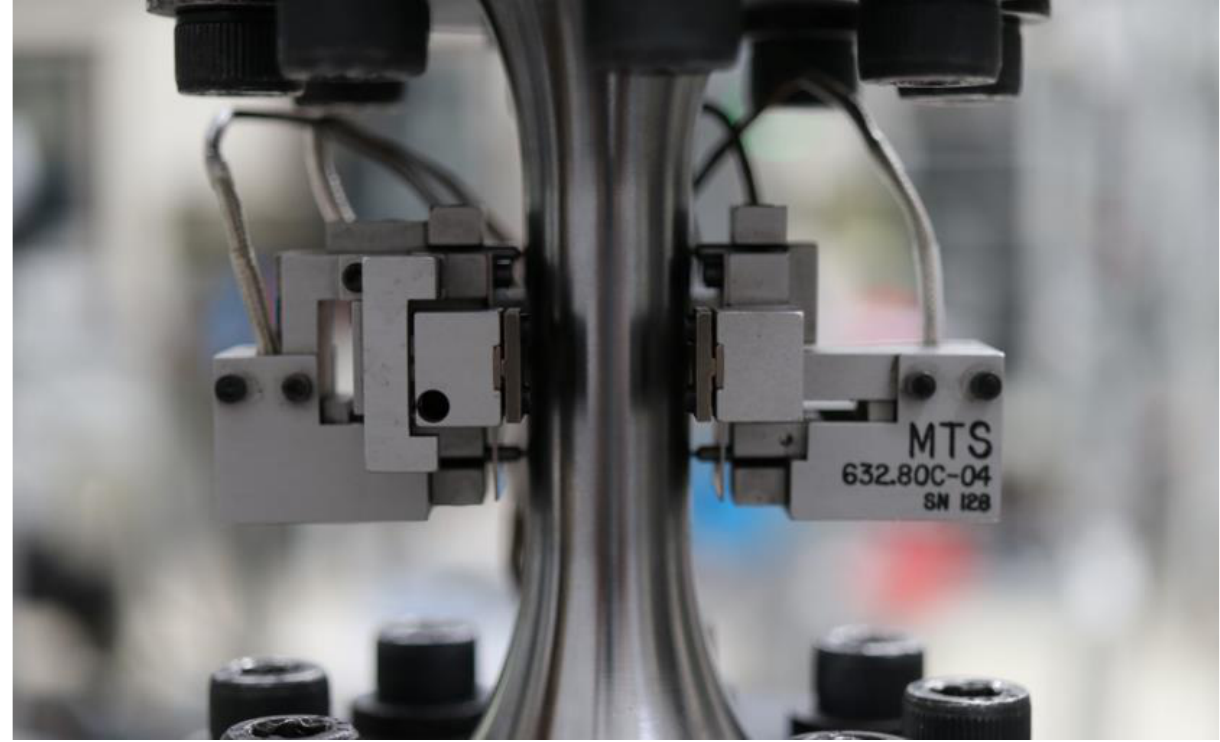
Figure A3. Multiaxial extensometer. Figure A3.